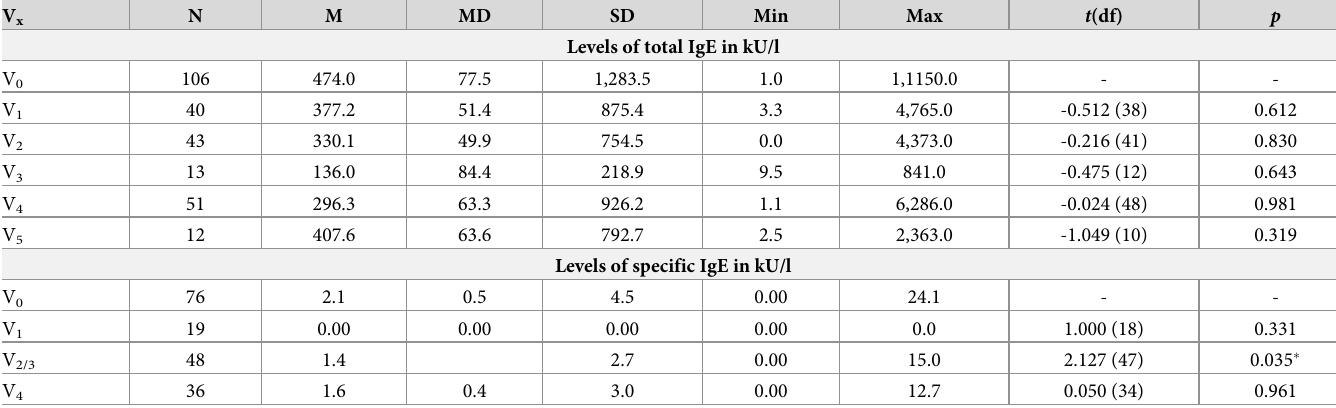
Table 5. Levels of total and E . multilocularis -specific IgE in kU/l over time and difference of respective levels compared to baseline. Vx = follow-up visit with V0 = baseline, N = number, M = mean, MD = median, SD = standard deviation; Min. = minimum, Max. = maximum, t = difference in units of standard error, df = degrees of freedom, p -value = significance level with � considered